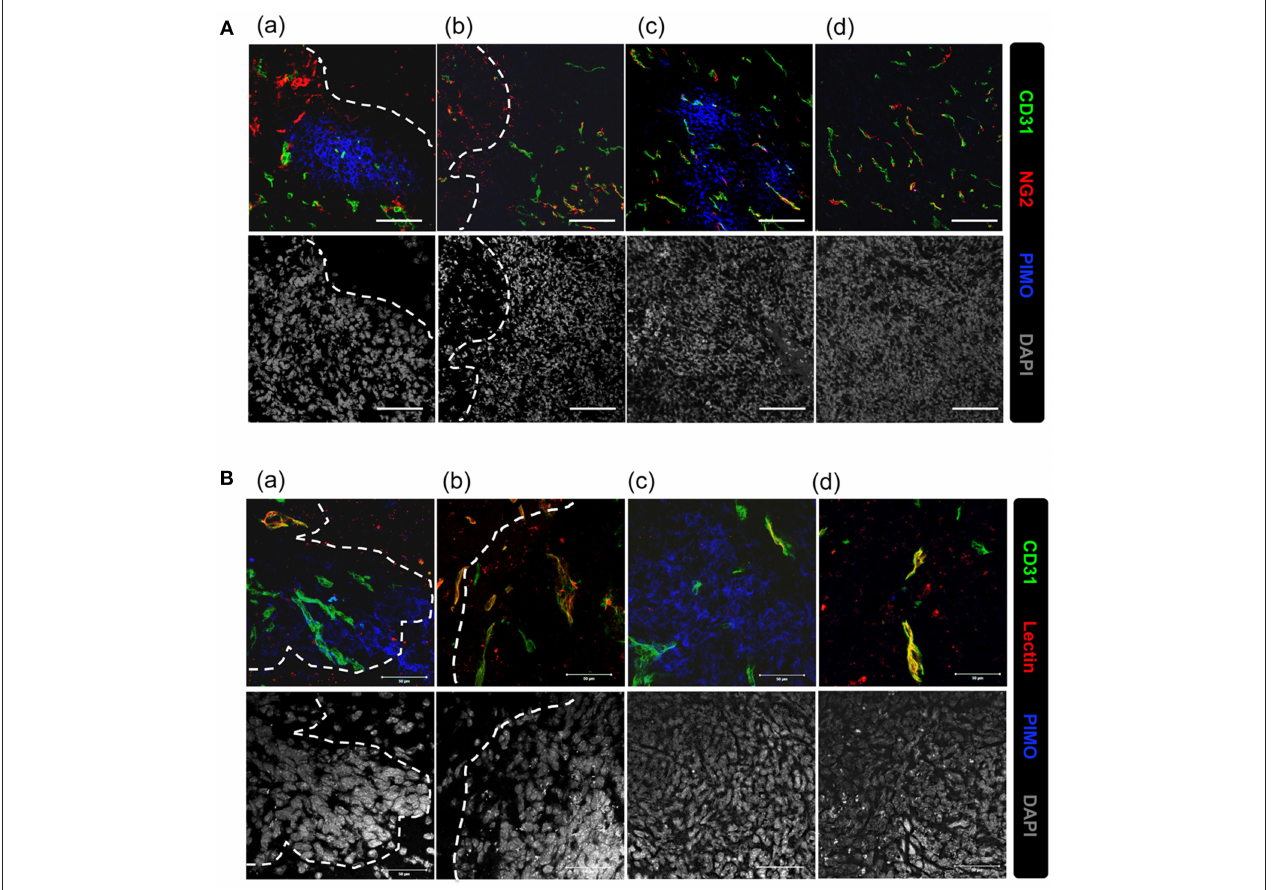
FIGURE 3 | Vascular malfunction, not vascular deficiency, caused the development of peripheral hypoxia. (A) Tumor sections were stained for PIMO (blue), CD31 (green), and pericyte marker, NG2 (red), and captured by confocal microscope. Nucleus was stained by DAPI (gray). Scale bar = 100 µ m. (B) Mice were i.v., injected with lectin (red) before sacrifice, and tissues were co-stained with PIMO (blue) and CD31 (green) for examining blood perfusion at tumor core and edge. Nucleus was stained by DAPI (gray). Tumor boundary was outlined by white dotted line. Scale bar = 50 µ m.